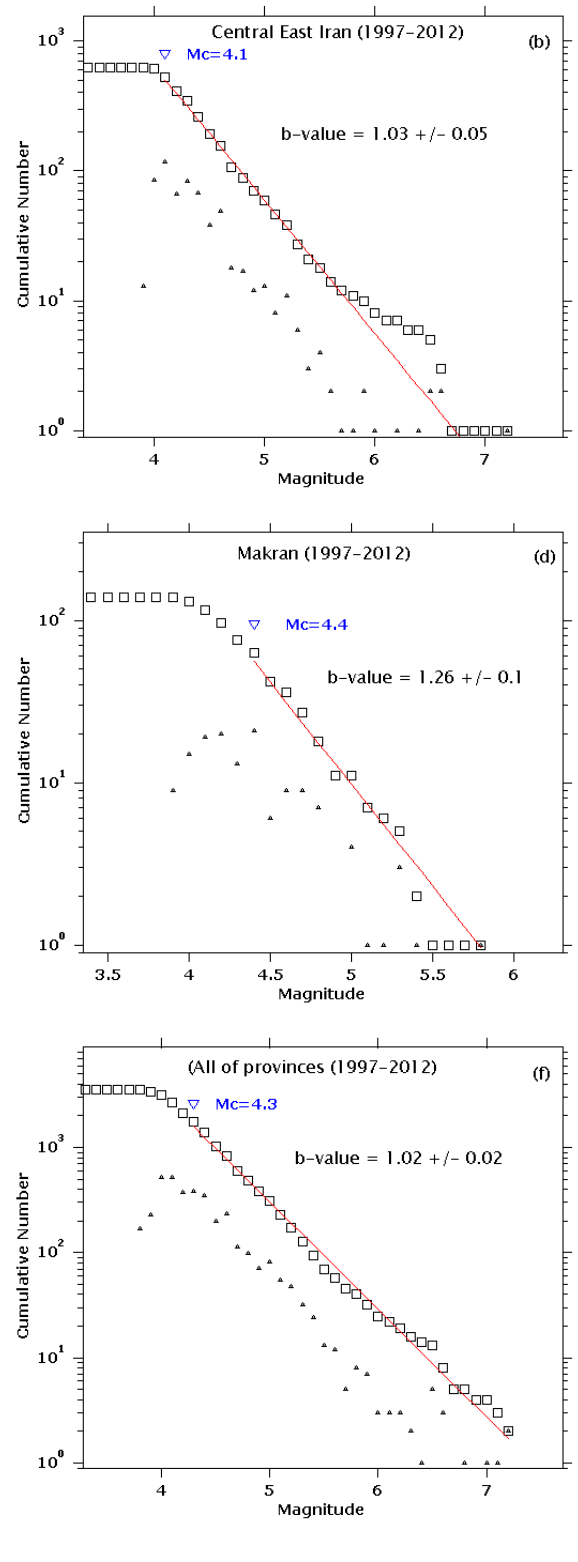
Figure 16. As Figure 14 for time interval